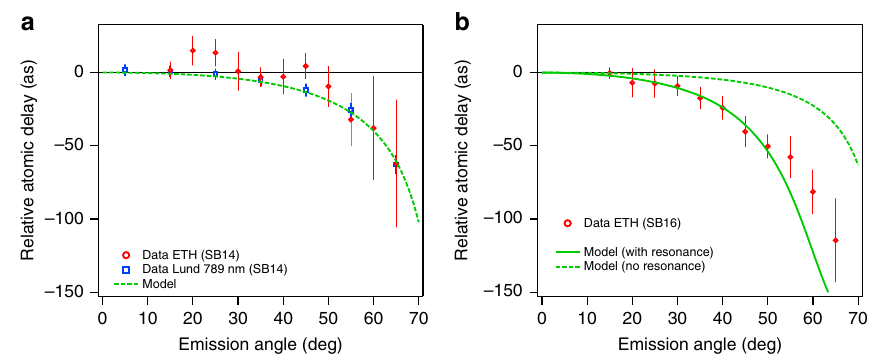
Fig. 5 Angular-resolved time delays. a , b show the atomic time delay (red symbols) as a function of electron emission angle for SB14 and SB16 (ETH experiment). Data obtained in Lund for SB14 are also indicated (blue open squares). The delays are referenced to the value retrieved for electrons departing within an opening angle of up to 30 degrees. The green lines show the calculated delays in resonant (solid) and nonresonant (dashed) conditions. The error bars indicate the standard deviation as extracted by a series of independent measurements